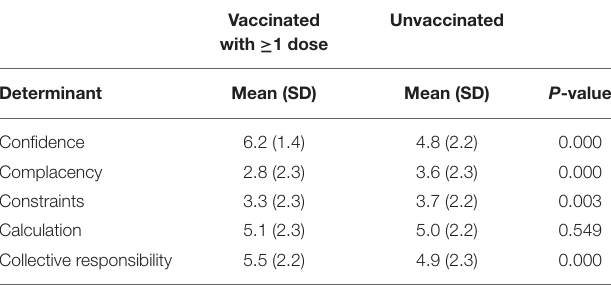
TABLE 6 | Means of the 5C scores between caregivers of vaccinated and unvaccinated girls and t -test p -values for statistical significance of difference. Vaccinated with ≥ 1